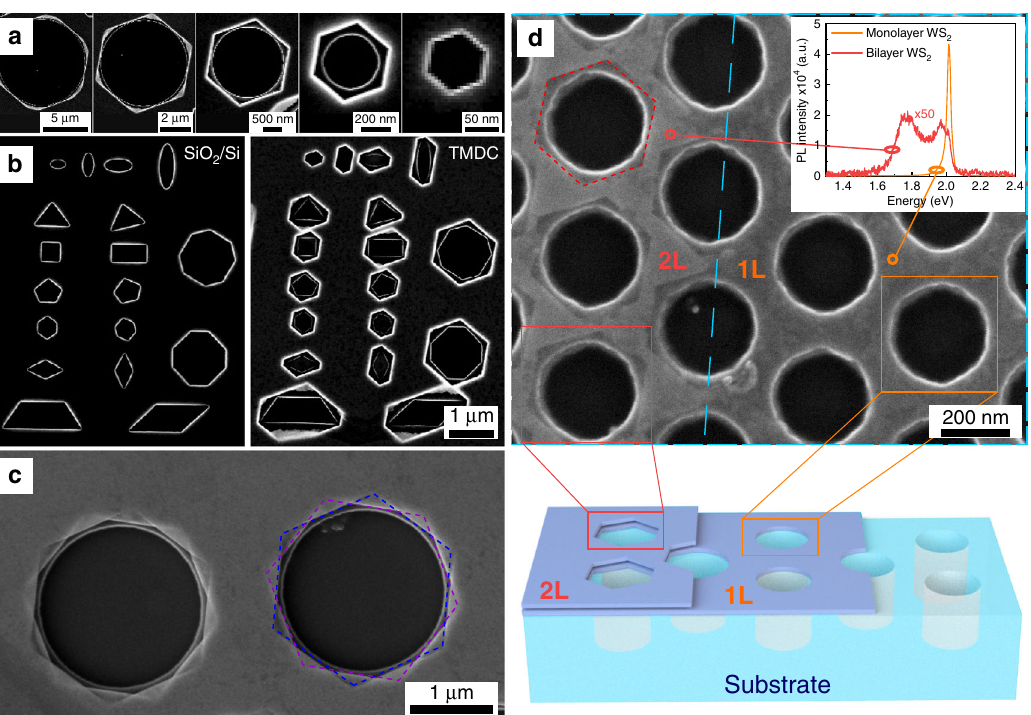
Fig. 2 Etching individual nanoholes. a Effect of hole size: SEM images of etched holes in WS 2 with various sizes from ~50 nm to ~10 µ m in diameter. b Effect of hole shape: SEM images of single holes with different initial shapes, such as pentagons, octagons, and ellipsoids, etched into both a bare SiO 2 /Si substrate and a WS 2 fl ake, illustrating the comparison between initial and anisotropically etched holes. c Effect of heterostructure: SEM image of etched hexagonal holes in a WS 2 multilayer heterostructure that has a 30° rotation between the stacked fl akes. d Effect of fl ake thickness: an SEM image and a corresponding schematic sketch showing formation of hexagonal holes in a bilayer and circular holes in monolayer WS 2 . The inset shows the photoluminescence spectra of bi- (red curve) and mono-layer (orange curve) WS 2